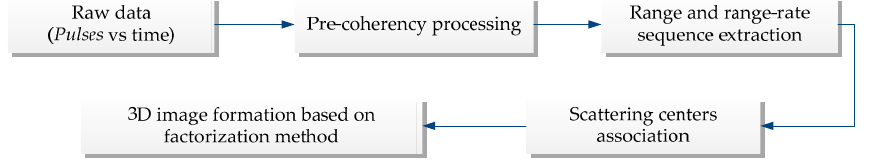
Figure 2. 3D space spinning target imaging methodology.